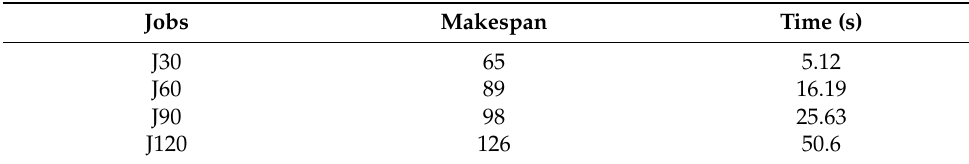
Table 7. The genetic algorithm mean